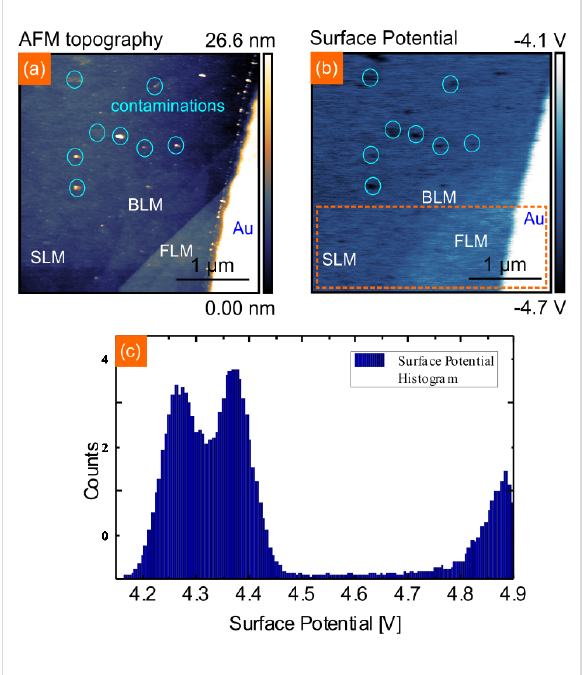
Figure 3: (a) NC-AFM image of MoS 2 flake on SiO 2 with a gold contact (height = 20 nm). Topography shows areas with contamina- tions due to processing. (b) Corresponding surface potential image to (a). The surface potential of MoS 2 is increasing with increasing layer thickness, contaminations can be clearly distinguished in the surface potential image. (c) Surface potential histogram of the box marked in